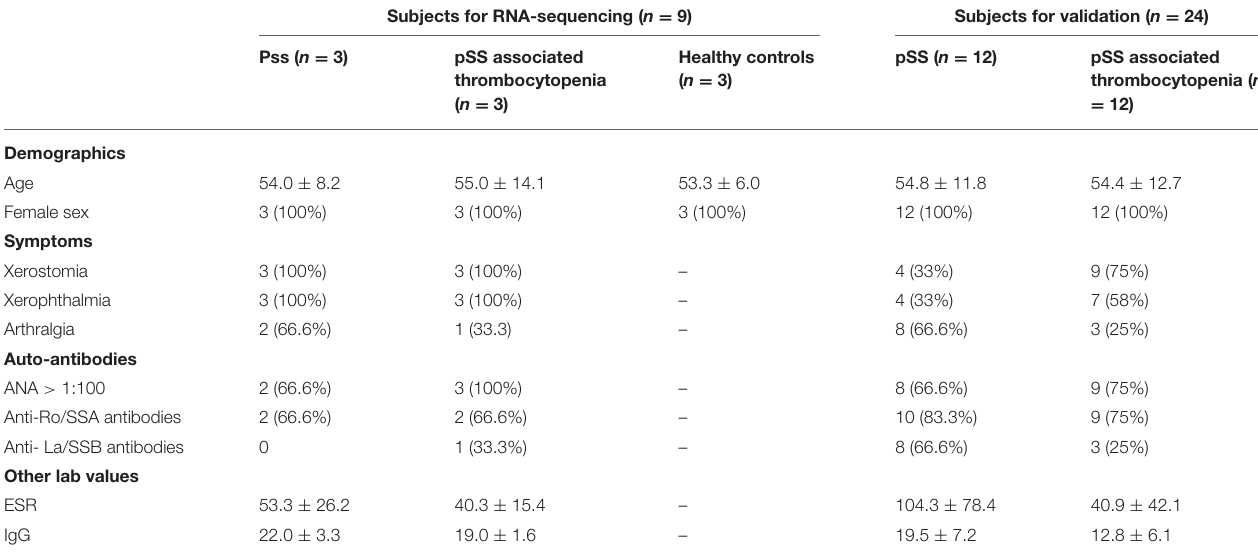
TABLE 1 | Study population